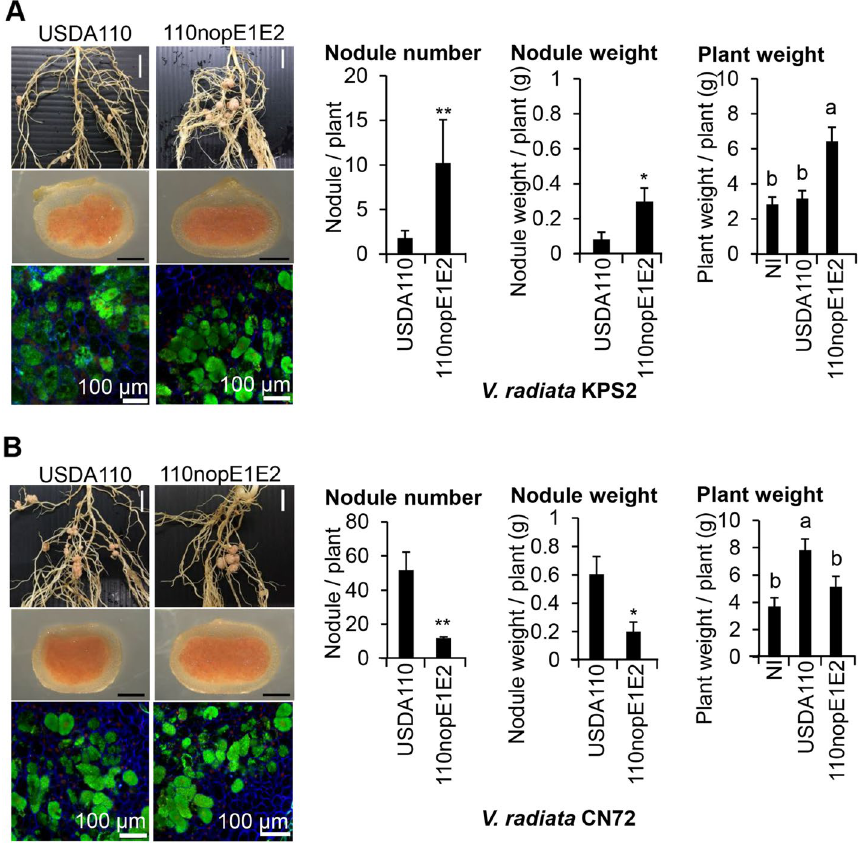
Figure 3. Nodulation properties of V. radiata cv. KPS2 (A) and its derived strain CN72 (B) inoculated with B. diazoefficiens strains. The roots were imaged at 35 dpi. The data shown are the means of at least 6 plants. Scale bars: 1 cm, entire roots; 1 mm, nodule morphology; and 100 µm, bacteroid observations with propidium iodide (PI)/SYTO9 staining of sectioned nodules. “*” P < 0.05 and “**” P < 0.01 according to Student’s t -test. The means followed by different letters are significantly different at the 5% level ( P ≤ 0.05 according to Tukey’s